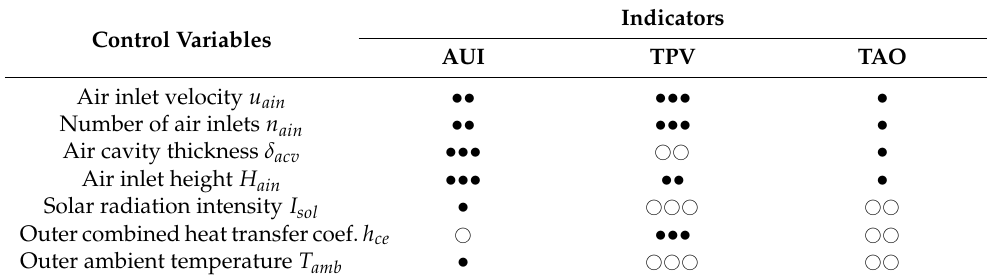
(cid:35)(cid:35) • represents that the indicator is trending opposite to the variable, while